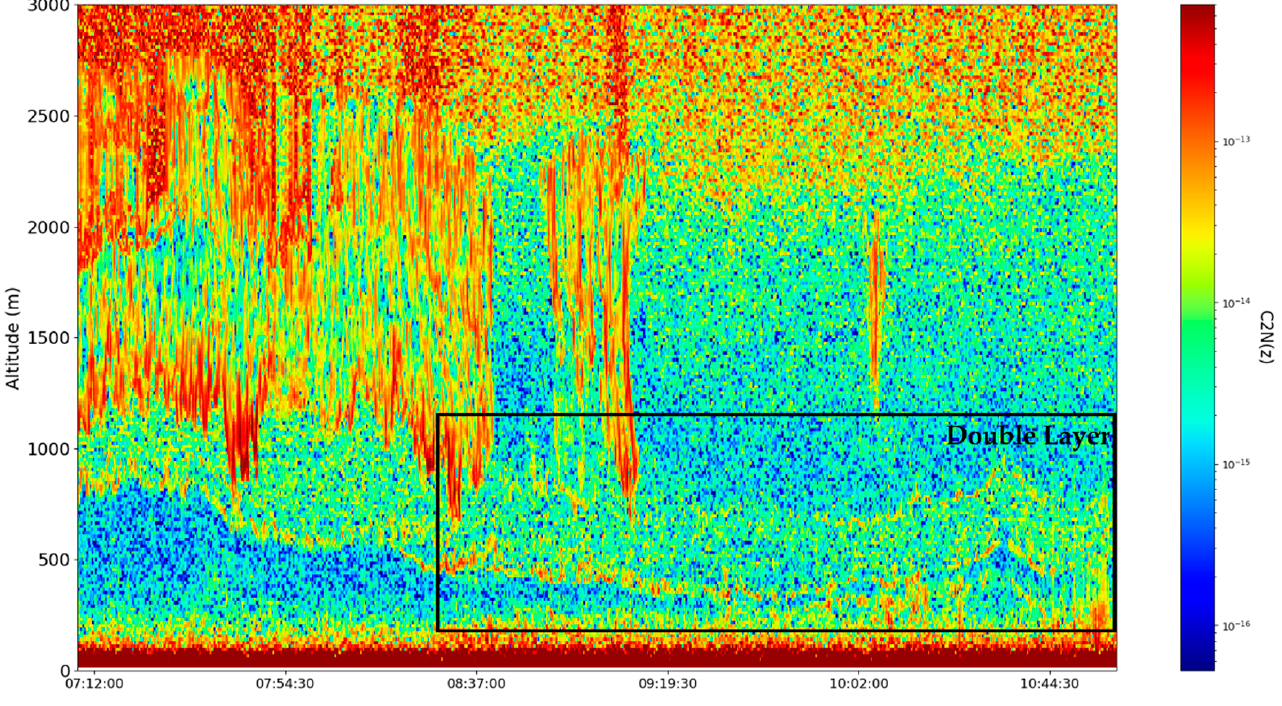
time series, λ = 1064 nm, Galat N